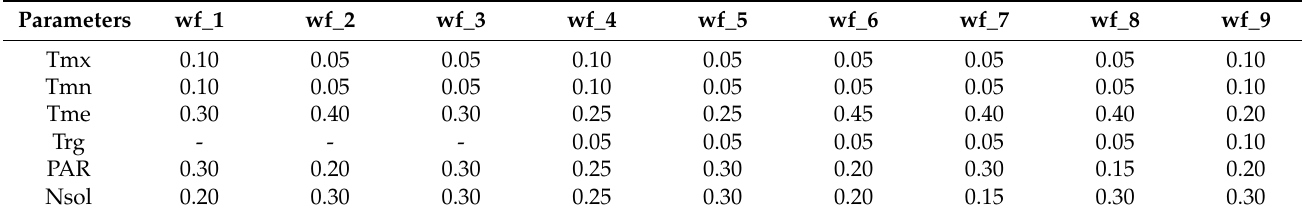
Table 1. Weighting factor (wf) options to obtain the weighted